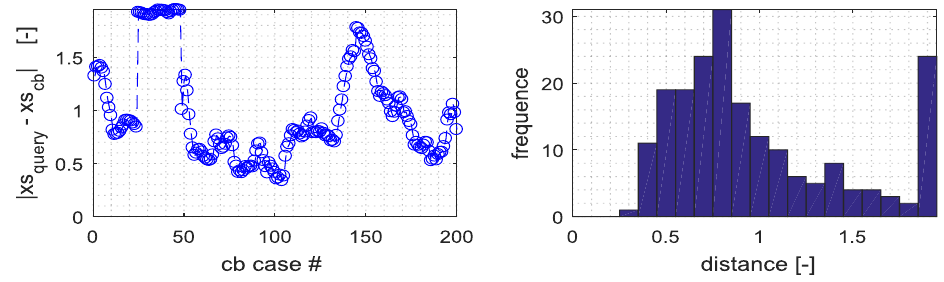
Figure 9. Distances from NN 2th val. hour, Hist. Distances from NN, Distance y query.